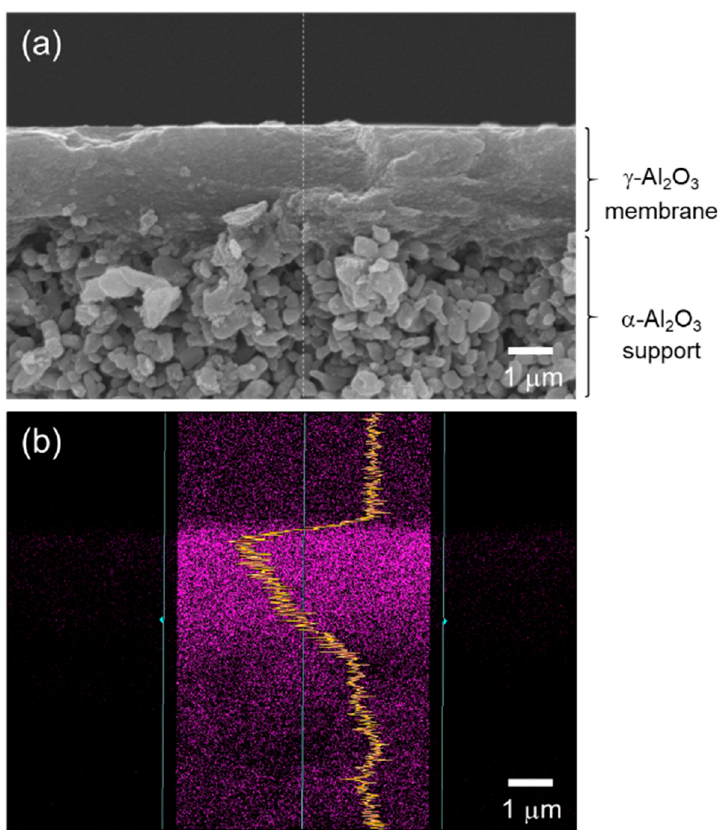
Figure 3. ( a ) A typical cross-sectional SEM image of the γ -Al 2 O 3 membrane on a microporous α -Al 2 O 3 support after modification with AHPCS and subsequent heat treatment at 400 °C in Ar. ( b ) Line scan of EDS mapping for Si derived from AHPCS detected within the mesoporous γ -Al 2 O 3 membrane having a thickness of approximately 2.5 μ m.